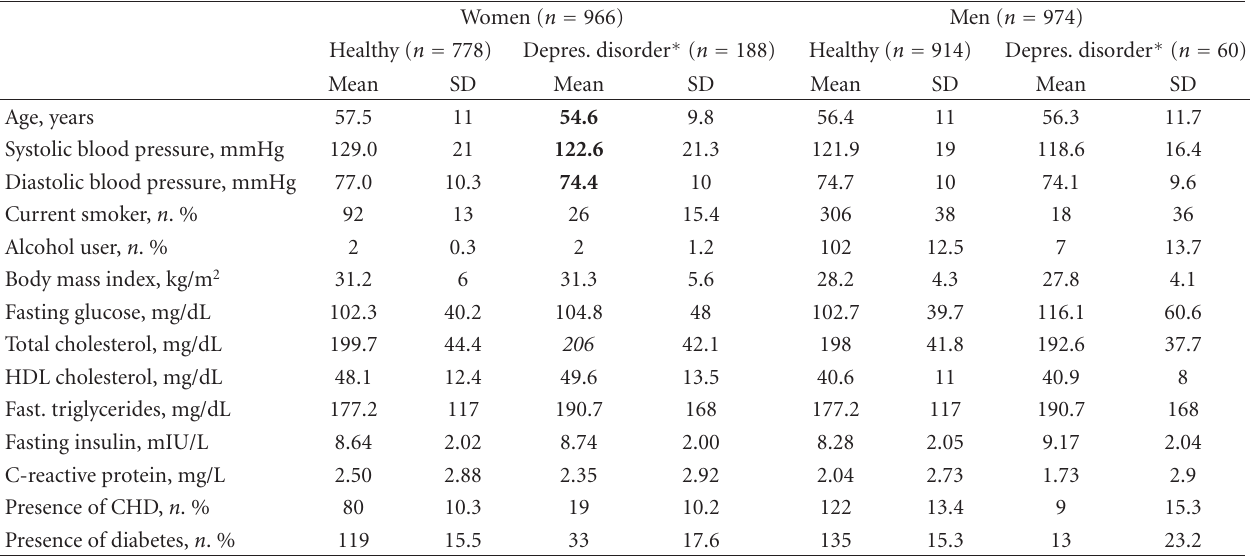
Table 1: Baseline characteristics of the sample population ( n = 1940), by gender and mental disorder.